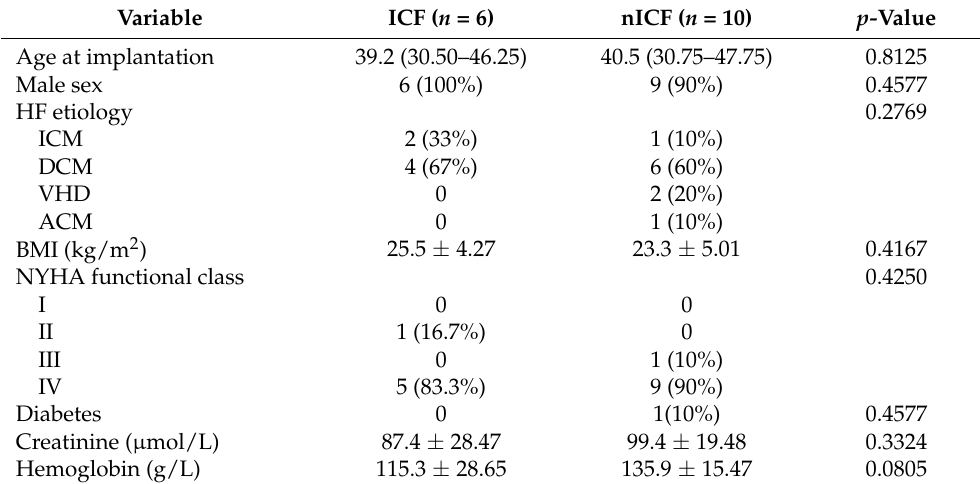
Table 1. Clinical characteristics of